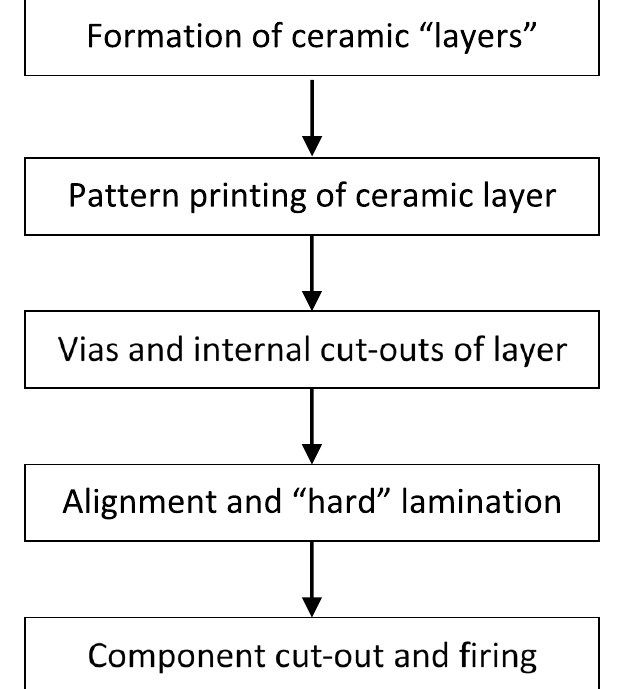
Figure 1. Fabrication process from LTCC ceramic transducer.